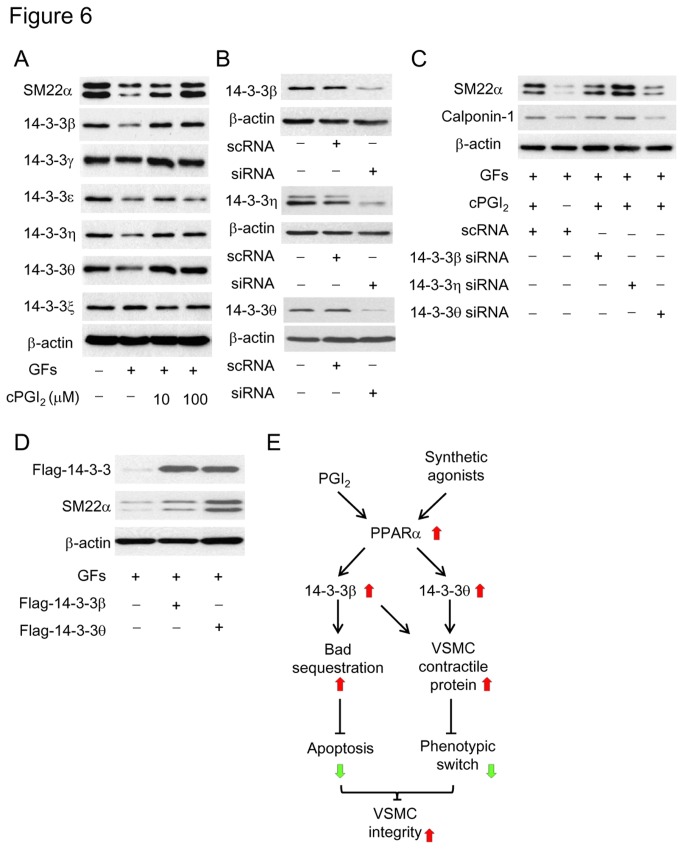
Prostacyclin prevents contractile protein reduction induced by combined growth factors (GFs).(A) Cells were pretreated with cPGI2 followed by GFs. (B) VSMCs were transfected with 14-3-3β, η or θ siRNA or a control scRNA and the respective 14-3-3 proteins were analyzed. (C) VSMCs transfected with siRNA of 14-3-3β, η or θ were treated with cPGI2 (100 µM) and GFs. SM22α and Calponin-1 in cell lysates were analyzed by Western blotting. (D) VSMCs were transfected with Flag-tagged 14-3-3β or θ vectors. Following GFs treatment, cells were lysed and SM22α was determined by Western blotting. All blots are representative of n≥3. (E) A schematic illustration of the role of PGI2/PPARα/14-3-3β and θ in controlling VSMC apoptosis and contractile phenotype.